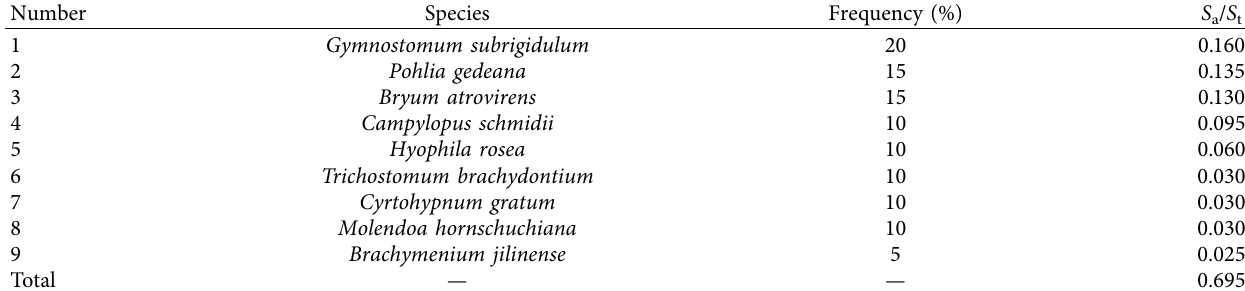
Table 4: Top 9 bryophytes species collected from mine waste slag areas.